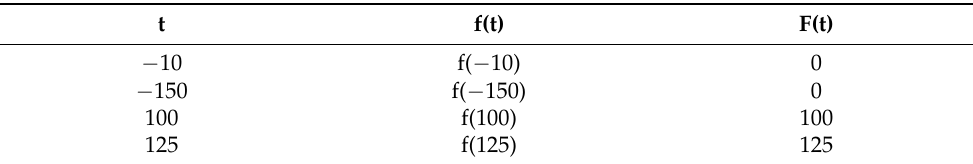
Table 3. Operation of Relu Activation Function.